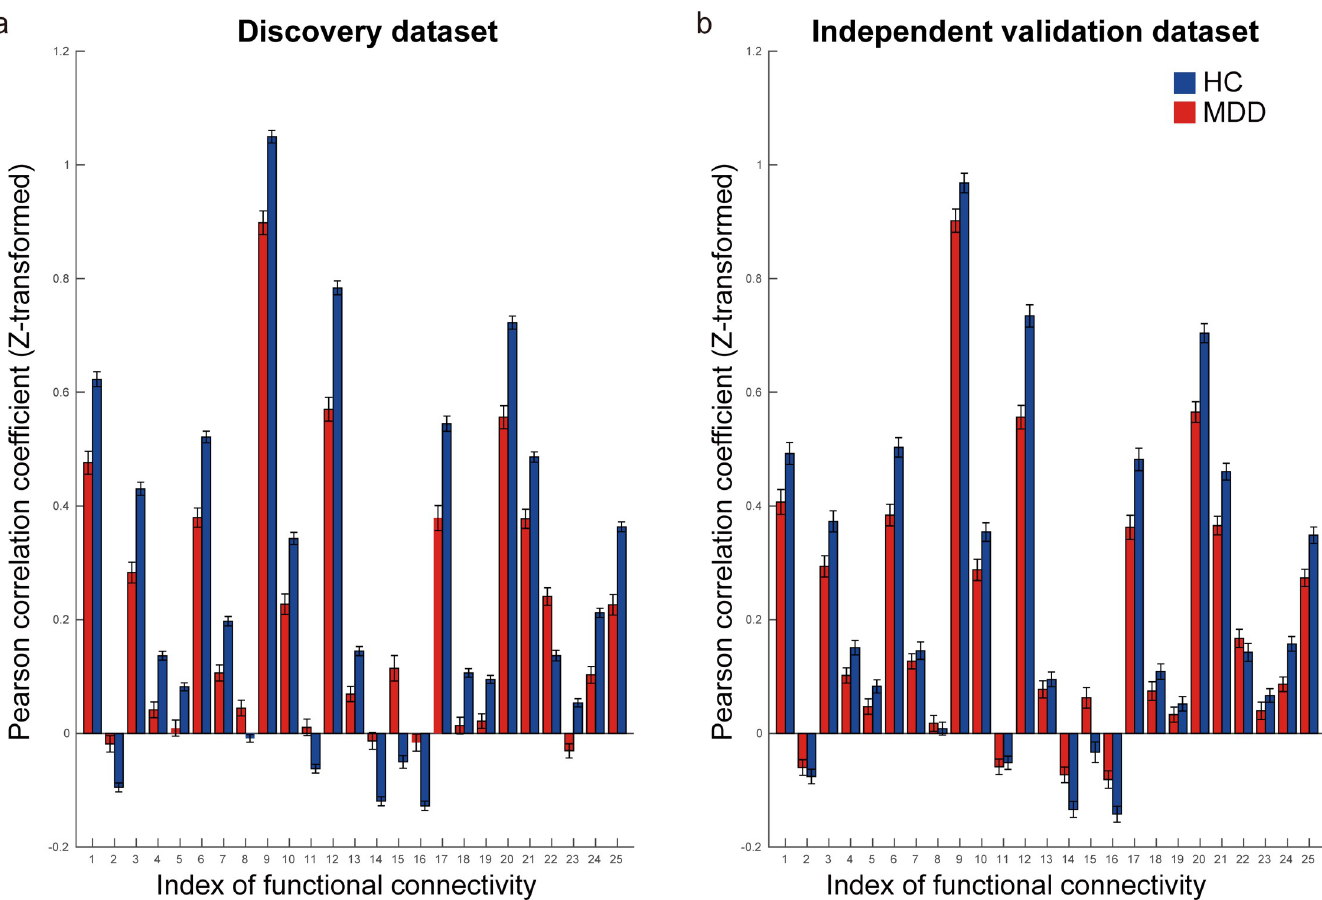
Fig 5. Reproducibility of important FCs for MDD diagnosis. (a) The FC values for both HCs (blue bar) and patients with MDD (red bar) in the discovery dataset. (b) The FC values for both HCs and patients with MDD in the independent validation dataset. The error bar represents the standard error. The numerical data used in this figure are included in S1 Data. FC, functional connectivity; HCs, healthy controls; MDD, major depressive disorder.